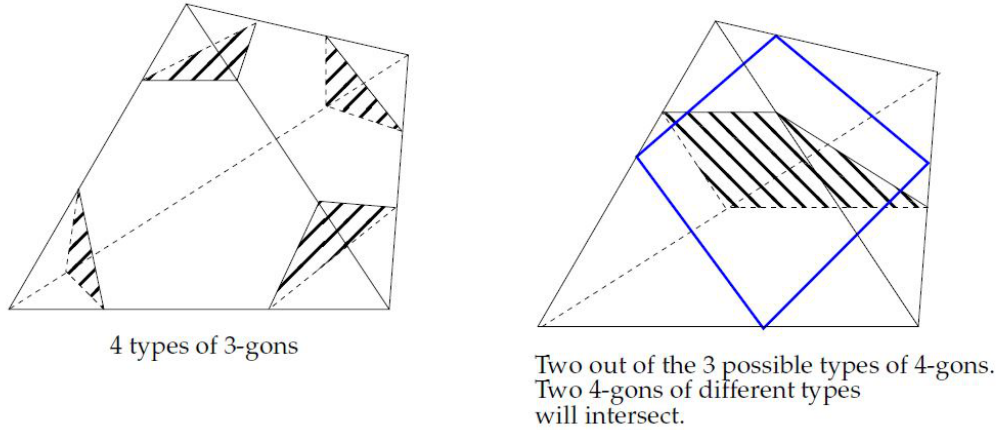
Figure A2. Normal